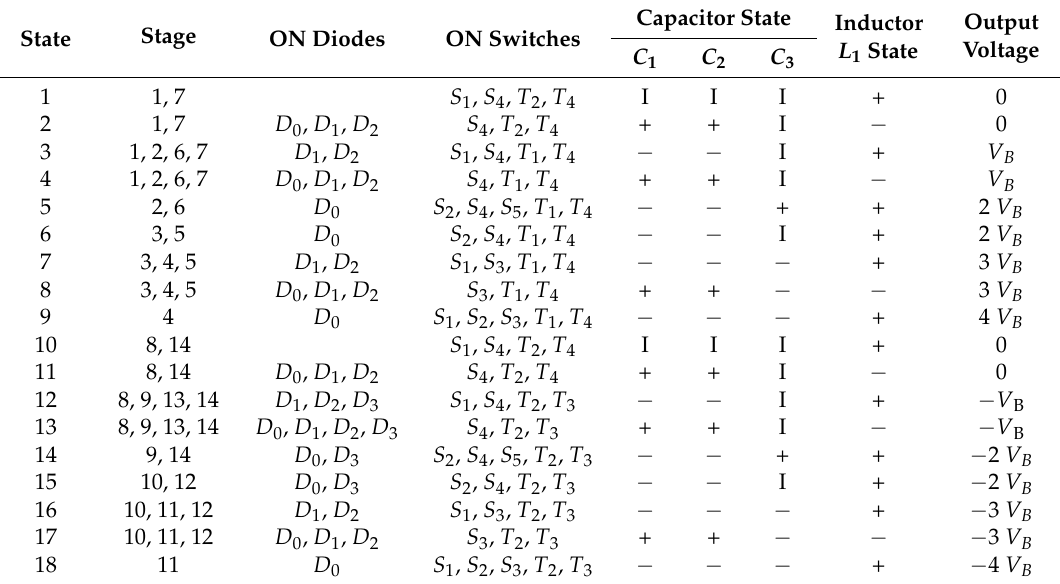
Capacitor State Inductor L 1 State